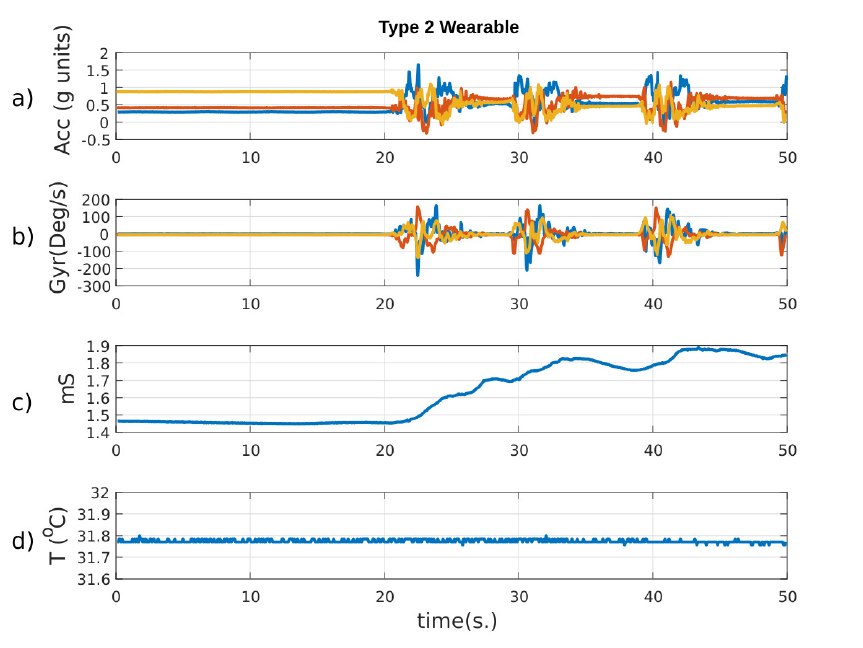
Figure 12. Main signals delivered by the Type 2 wearable during sit-to-stand exercise. From top to bottom: ( a ) 3-axis accelerometer data in g units; ( b ) 3-axis gyroscope data in deg/s; ( c ) skin conductance, and ( d ) skin temperature. At 20, 30, and 40 s the subject performed several movements that are reflected as oscillations in the IMUs and as an increase in the skin